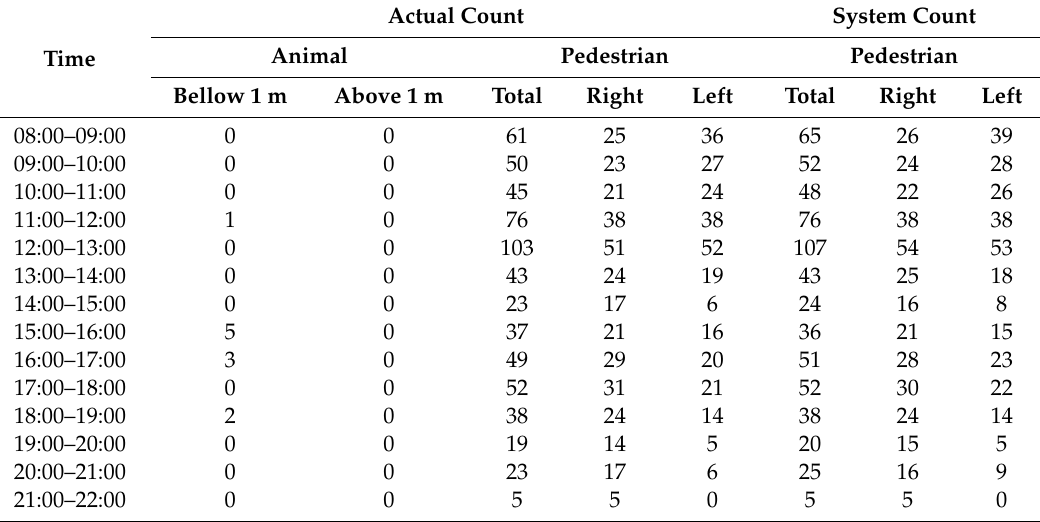
Table 4. Actual and system pedestrian count in the